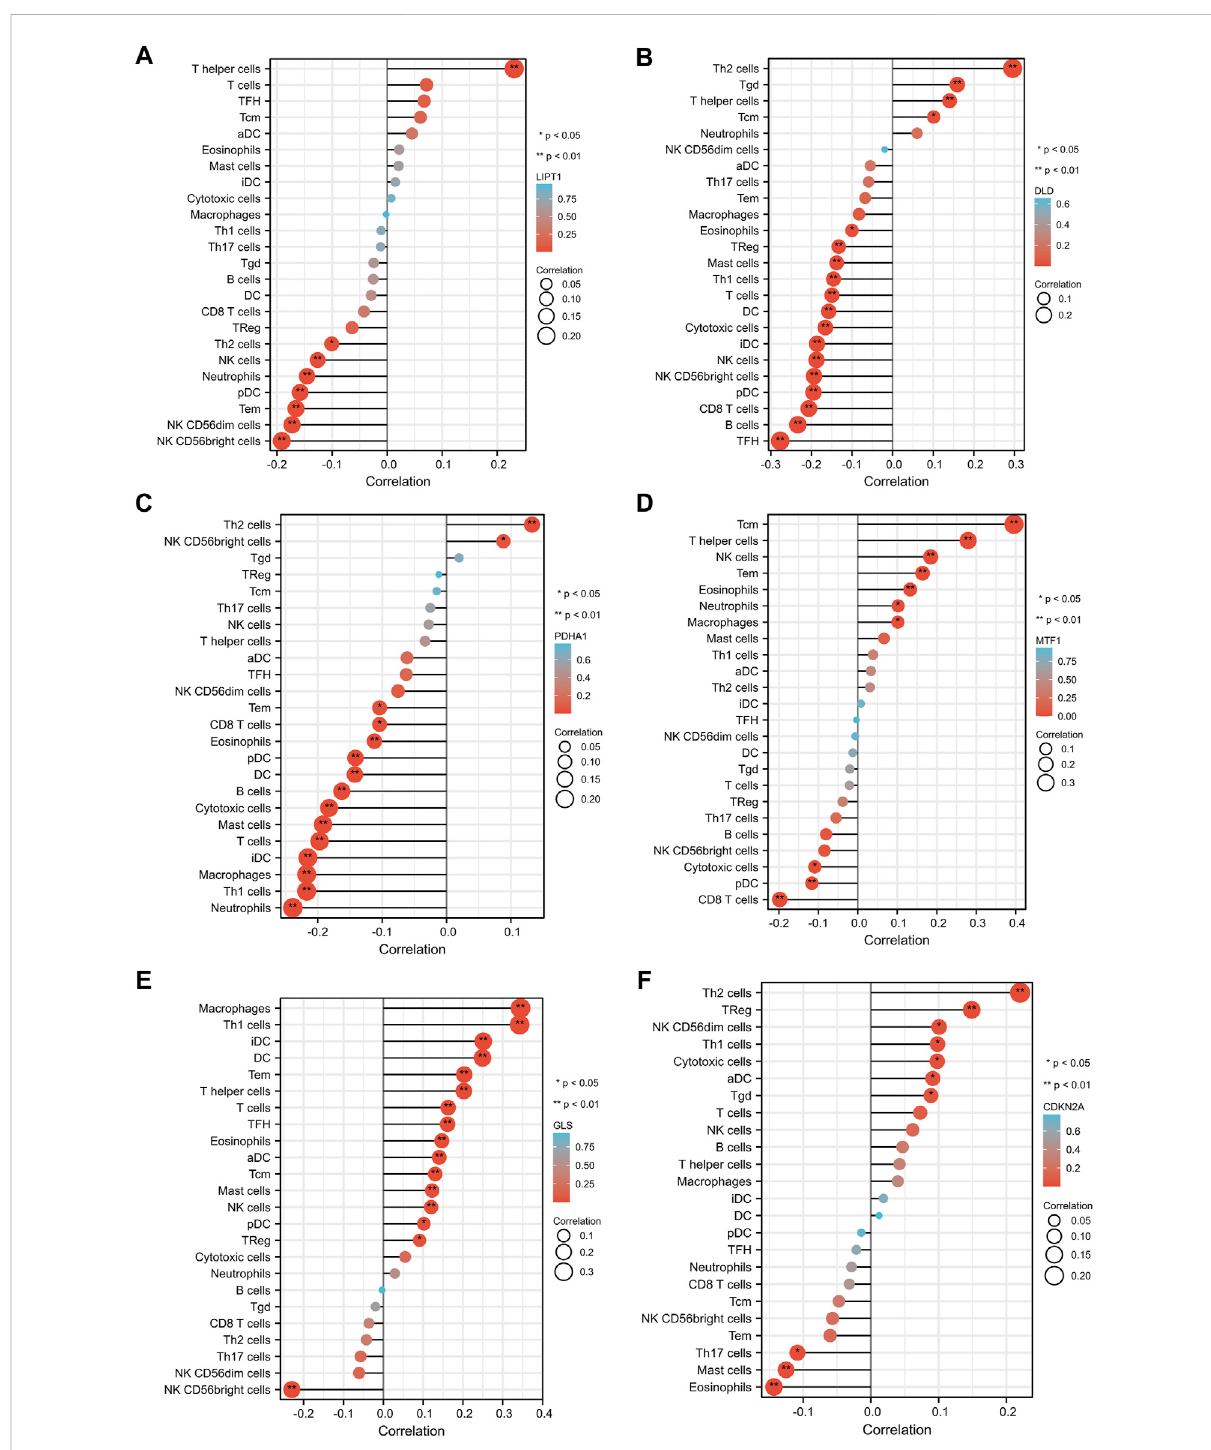
FIGURE 5 CorrelationbetweenthesixprognosticCRGsandimmunein fi ltrationinLUAD.ThecorrelationbetweenLIPT1 (A) ,DLD (B) ,PDHA1 (C) ,MTF1 (D) , GLS (E) , CDKN2A (F) , and the degree of immune in fi ltration of 24 immune cell types in patients with